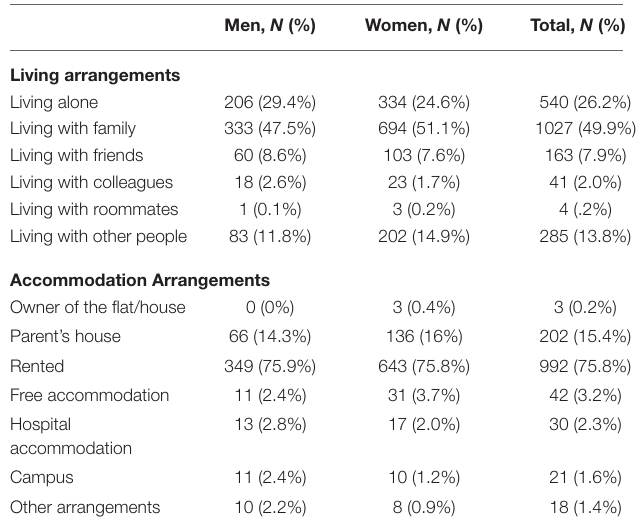
TABLE 3 | Living arrangements (house sharing and ownership). TABLE 4 | Migrating alone or with